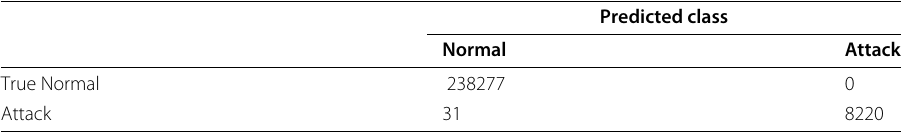
Table 10 Results of the classification approach: confusion matrix for a medium tree applied to test data for the